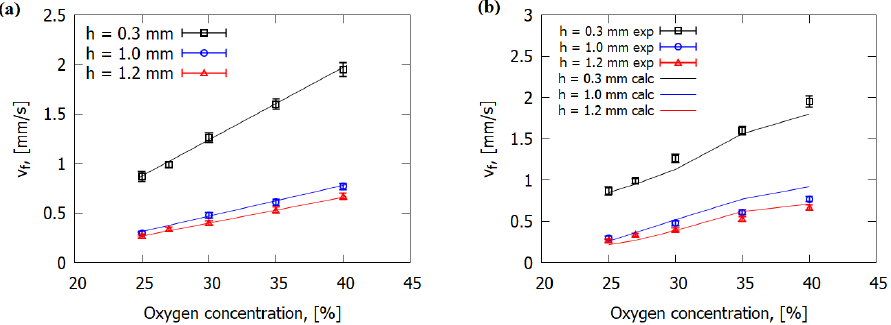
Figure 6. Dependence of the rate of flame propagation over GFRER on the oxygen concentration in the flow. Experiment and linear approximation ( a ); experiment and calculation ( b ).